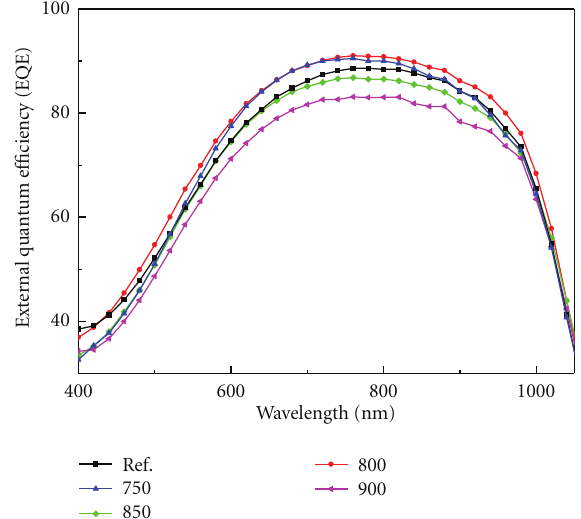
Figure 8: External quantum e ffi ciency (EQE) of nongettered and gettered